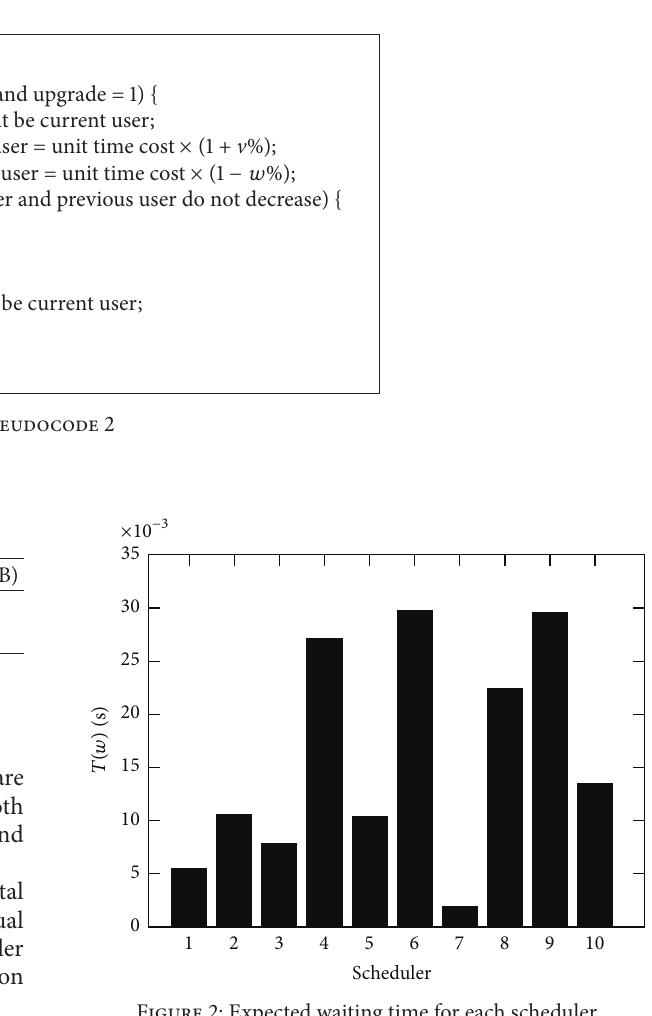
Figure 2: Expected waiting time for each